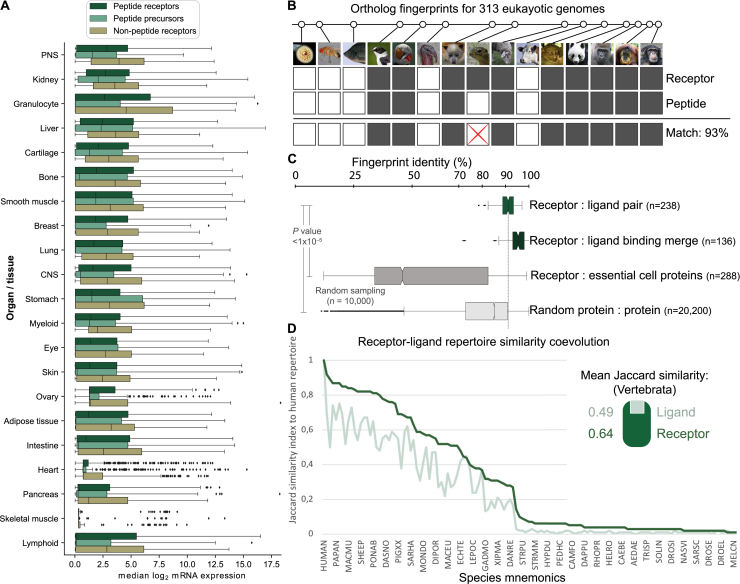
The Peptidergic Signaling System Has Been Shaped by Co-evolution of Ligands and Their Receptor Targets, Related to Figure 1(A) Receptors and their ligands are ubiquitously expressed in human organs and tissues. The data is ordered by mean level of peptide receptor expression. Peptide receptors consistently had lower median expression levels than non-peptide GPCRs. Similar peptide receptor-ligand expression levels were observed for liver and smooth muscle, whereas granulocytes and lung tissue had higher expression of receptors than ligand precursors (Wilcoxon rank sum test; P values: < 1x10−5 (granulocytes) and 0.02 (lung)).(B) Evolutionary fingerprints indicated conservation (gray) or absence (white) of receptor and peptide precursor gene orthologs in 313 species (representatives shown). The fingerprint identity (%) reflects the evolutionary relationship of peptide-receptor pairs. Photos from Ensembl genome database project.(C) The average percentage identity of evolutionary receptor-ligand pairs for all endogenous receptor-ligand pairs is increased when fingerprints of ligands for the same receptor are merged and is greater than for a random protein pair (permutation tests by performing 10,000 randomizations, Wilcoxon rank sum test P value < 1x10−5).(D) Jaccard index similarity of human peptide receptor and ligand precursor repertoires (n = 131 and 130, respectively) to selected species ordered by evolutionary distance. Data in Tables S1 and S2.